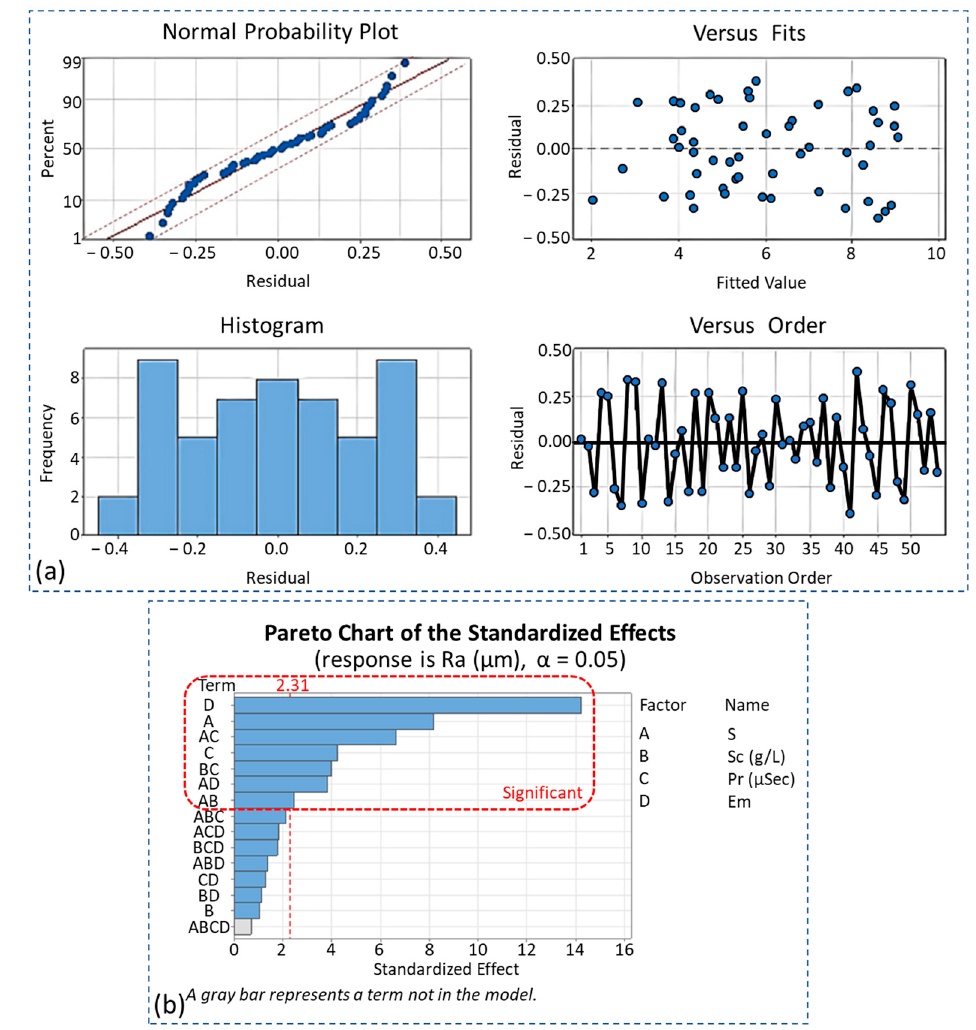
Figure 3. ( a ) Quantitative-based analysis on model adequacy and statistical confidence, and ( b ) Pareto chart for the significance of process parameters.